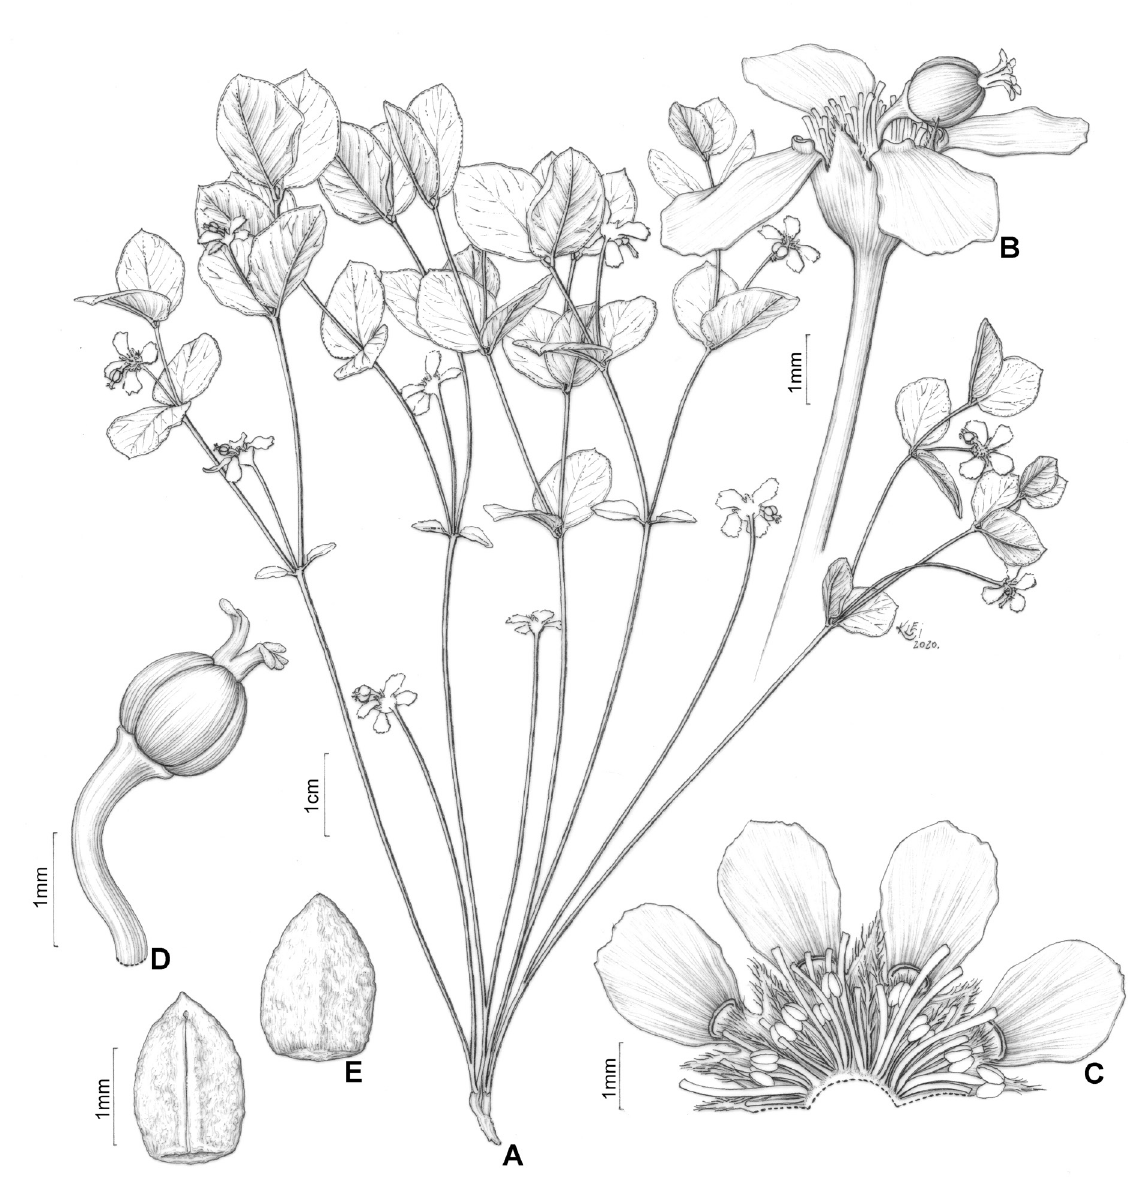
Fig. 3. Euphorbia longipedunculata O.L.M.Silva & Riina sp. nov. A . Habit. B . Cyathium, C . Opened cyathium, showing staminate cymules and bracteoles, D . Young fruit. E . Seeds in ventral (left) and dorsal (right) views. Illustrations of the holotype, B.M.T. Walter et al. 4688 (SP), by Klei